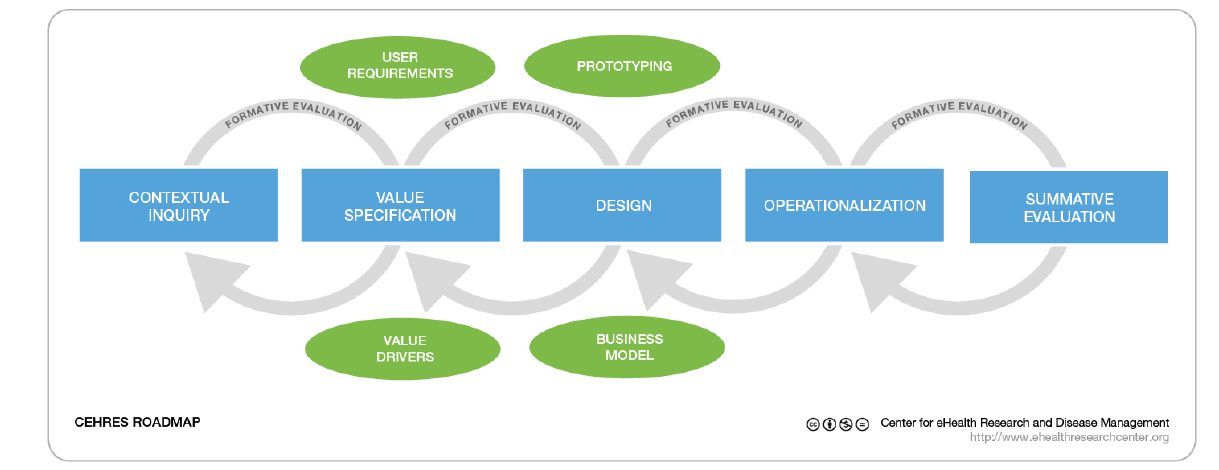
Figure 1. CeHRes